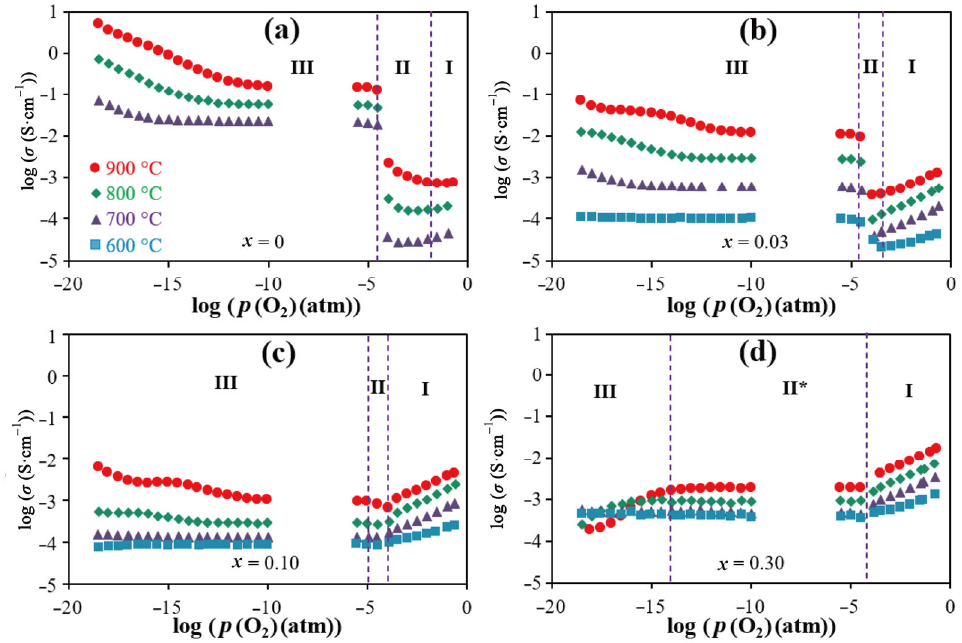
Fig. 8 Total σ of BaSn 1 − x Sc x O 3 − δ as a function of p (O 2 ) for (a) x = 0, (b) x = 0.03, (c) x = 0.10, and (d) x =